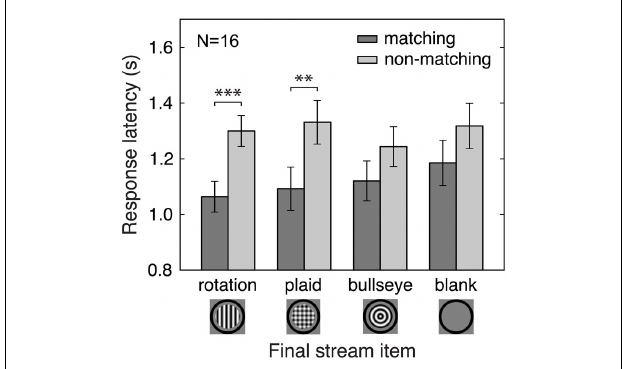
suggesting that prediction but not adaptation speeded perceptual report. Error bars are between-subject standard errors of the difference between matching and non-matching percept response latencies. ∗∗ p < 0.01; ∗∗∗ p <